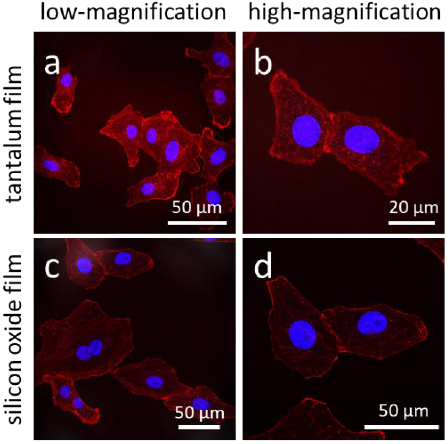
Figure 4. Fluorescence confocal micrographs of cells adhered on ( a,b ) blanket tantalum and ( c , d ) silicon oxide thin films. Images ( a ) and ( c ) were recorded at low-magnification while ( b , d ) at high-magnification. These cells are randomly oriented with irregular shapes. DNA was stained with DAPI in blue, while F-actin microfilaments were stained with CytoPainter F-Actin in red. Cells were incubated on the engineered surfaces for 24 h.